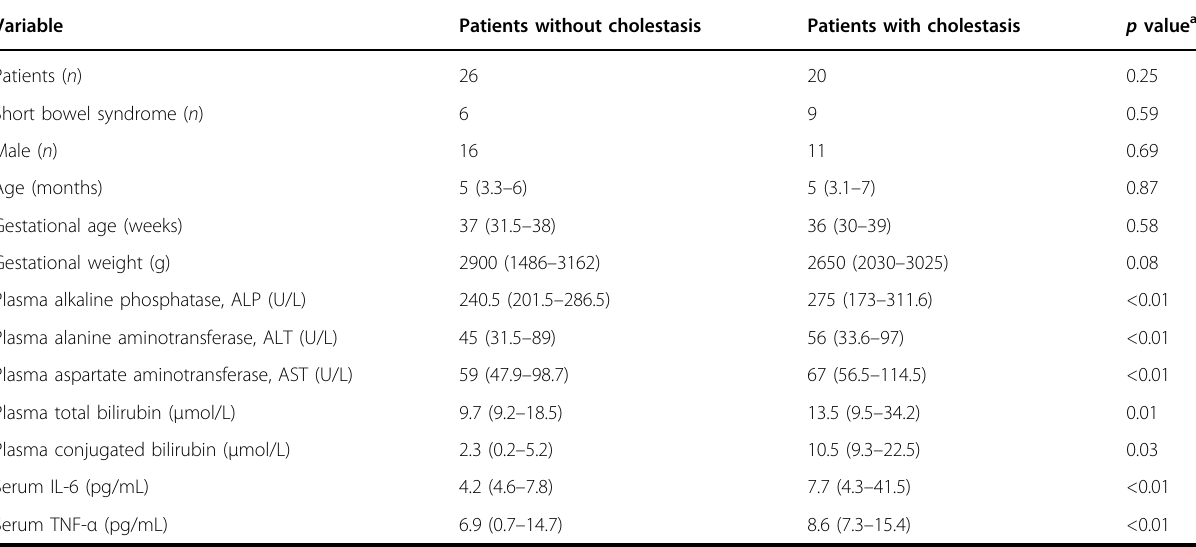
Table 1 Characteristics of the